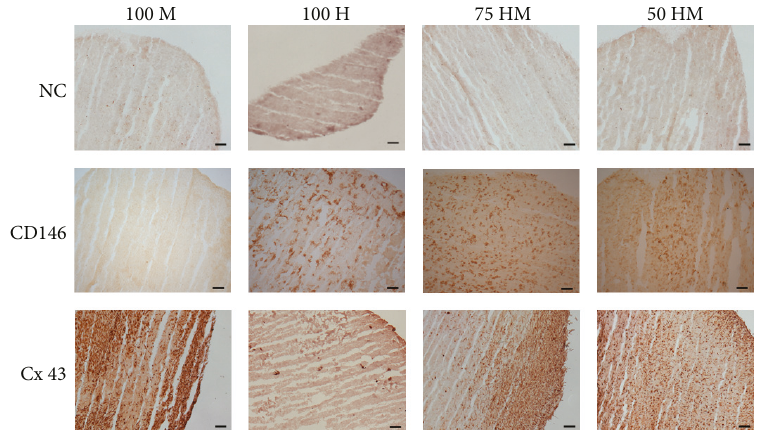
Figure 7: Immunohistology for CD146 and connexin 43 (Cx 43) of HUVEC and MSC mono- and cocultures in PRP at day 14. Immunohistology was performed on cryosections of mono- and cocultures with 100% MSCs (100M), 100% HUVECs (100H), 75% HUVECs – 25% MSCs (75 HM), and 50% HUVECs – 50% MSCs (50 HM) (seeding density: 2.5 × 10 3 cells/ μ l gel). Negative controls (NC) are shown in the fi rst row. In comparison to the NC, positive signals of CD146 were detectable in the presence of HUVECs, whereas connexin 43 protein levels were only apparent in a mono- or coculture with MSCs. Scale bars =100 μ